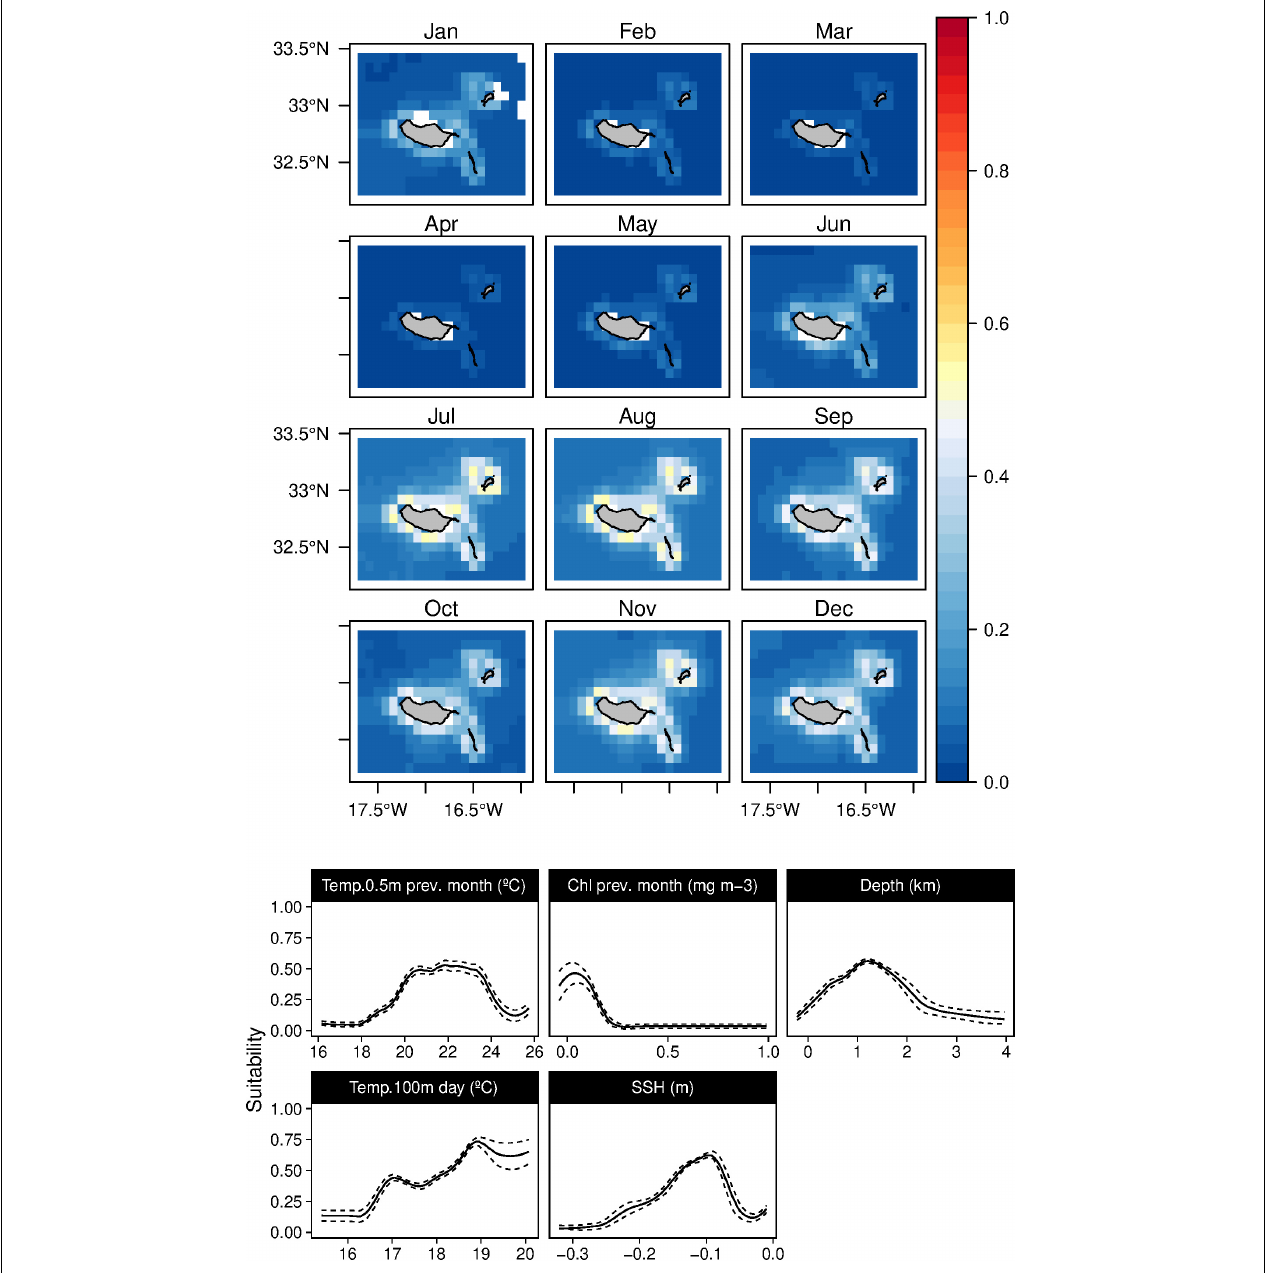
FIGURE 11 | Mean monthly suitability maps (above) and smoothed response curves with standard deviation (below) in the Madeira archipelago for Balaenoptera edeni for the “daily” models. In the maps, red represents more suitable and blue less suitable. Responses curves are ordered by percent contribution of the environmental